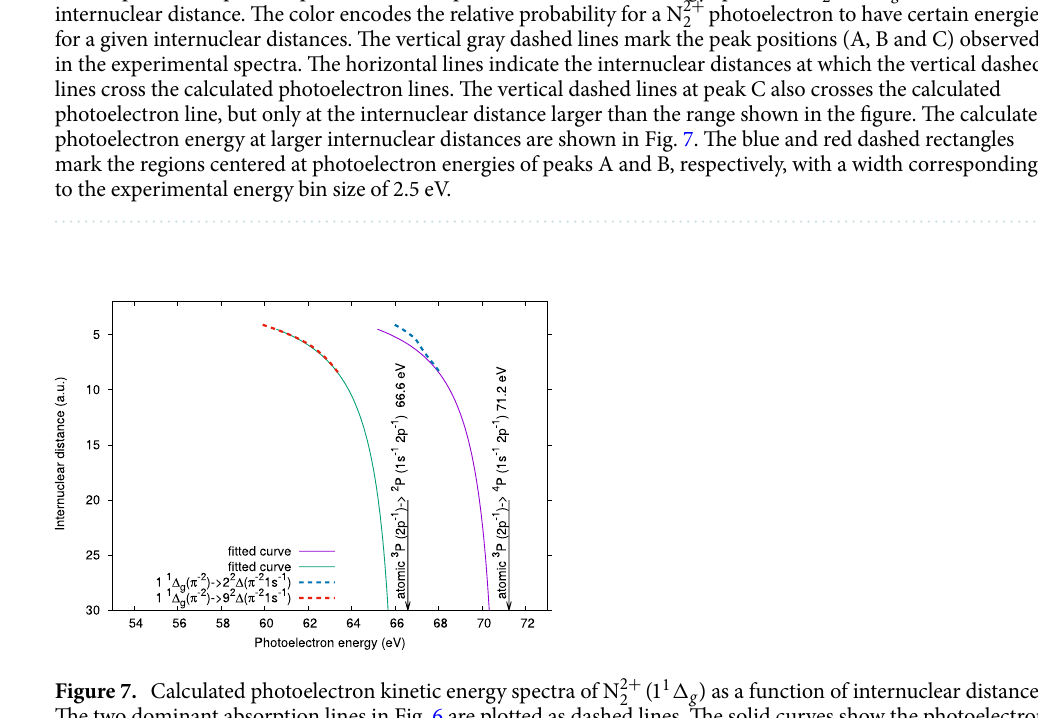
2 + 2 in the 2 1 1 (cid:31) + 2 ( g ) as a function of 2 + 2 photoelectron to have certain energies